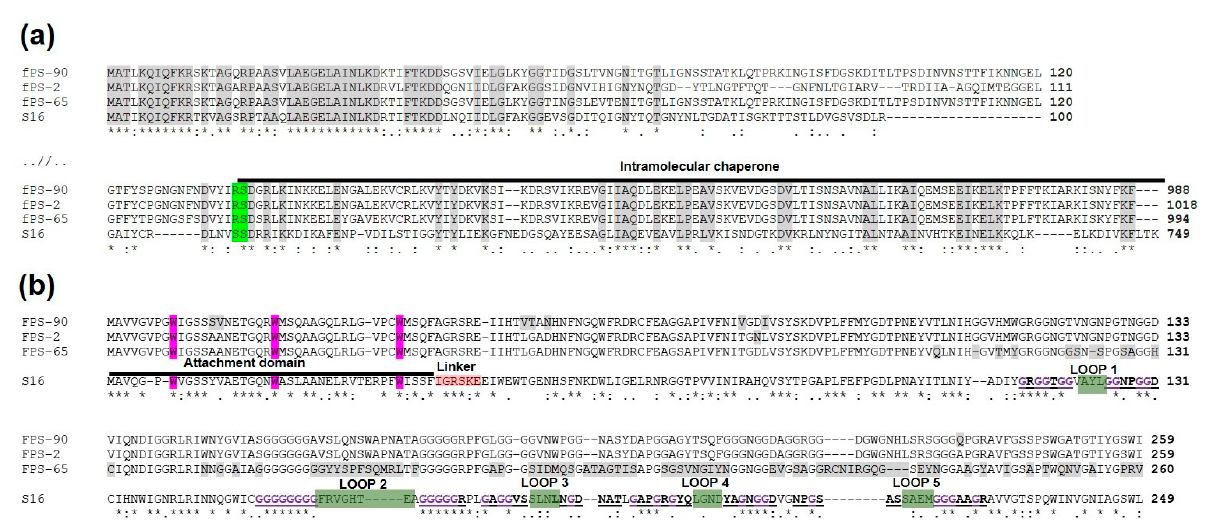
Figure 7. Multiple sequence alignments of Gp37 and Gp38 homologs of phages fPS-2, fPS-65, fPS-90 and Salmonella phage S16. Below the alignments symbols are used to indicate the similarity of the aligned amino acids: “*” indicates perfect alignment; “:” indicates that aligned amino acids belong to a group exhibiting strong similarity; “.” indicates that aligned amino acids belong to a group exhibiting weak similarity. Panel ( a ). Multiple sequence alignment of the N- and C-terminal sequences of the Gp37 homologs. Identical amino acids in all four sequences are highlighted in grey. The autocleavage site is highlighted in green and the intramolecular chaperone indicated by black line. Panel ( b ). Multiple sequence alignment of the sequences of the Gp38 homologs. Different functional regions are indicated for the S16 protein. The N-terminal attachment domain is indicated by a black line, and its critical N-terminal tryptophan residues are highlighted in purple. The linker sequence is highlighted in pink. The predicted receptor-binding loops 1–5 are indicated by green highlighting, and the flanking polyglycines in bold purple color with underlining. The differences between the fPS homologs are highlighted in grey.